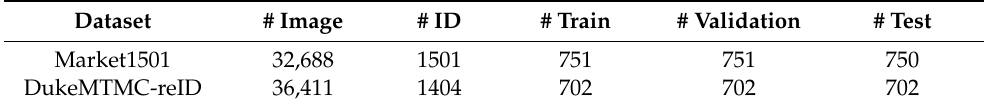
Table 1. Details of the datasets used in our